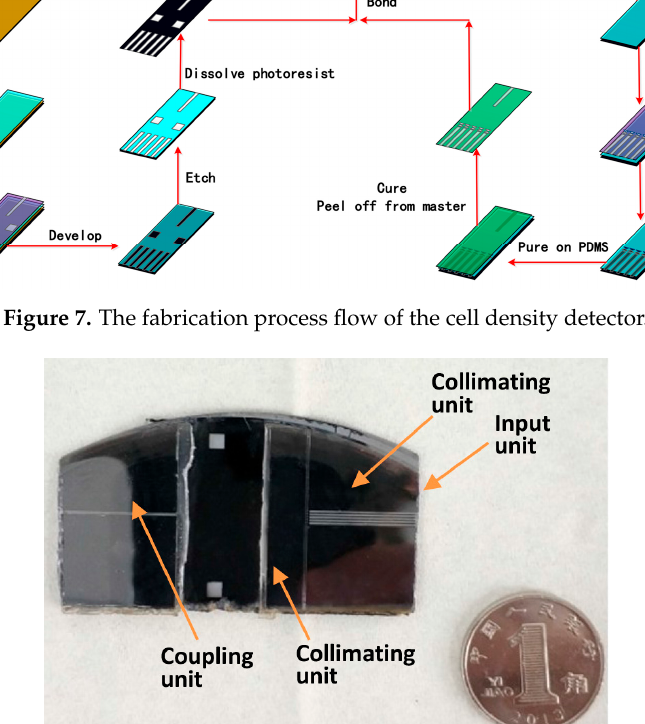
Figure 8. A photograph of the fabricated device together with a Chinese dime.